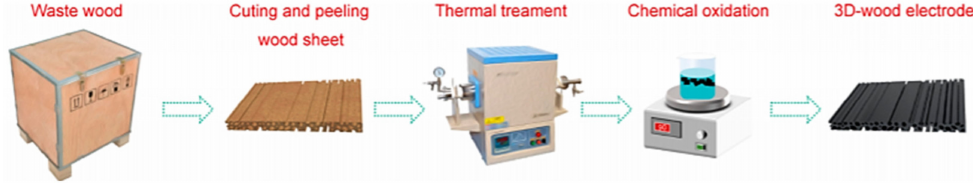
Figure 5. Schematic illustration of 3D-wood electrode synthesis